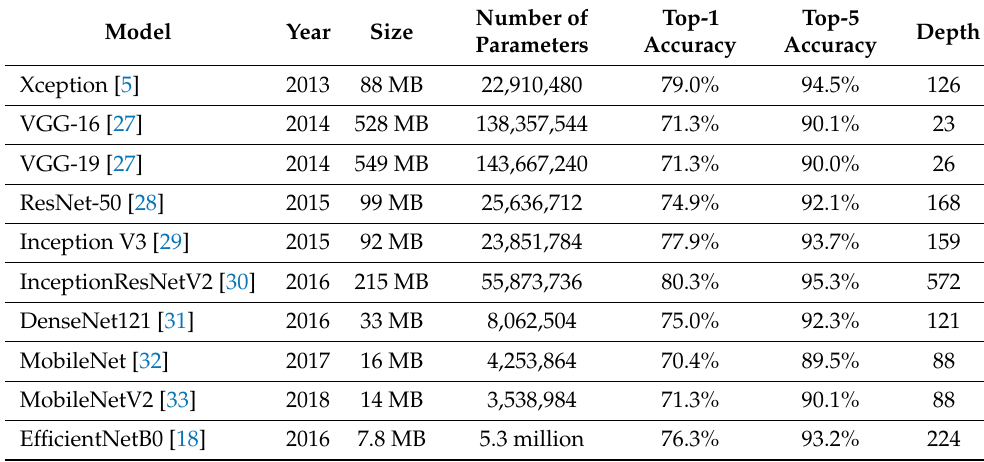
Table 1. CNN different pre-trained